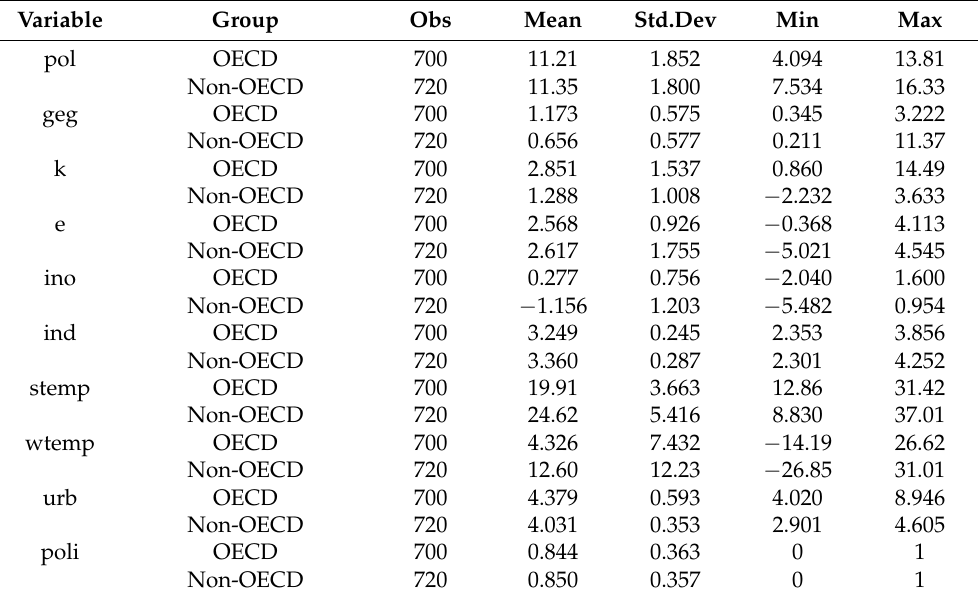
Table 3. Descriptive